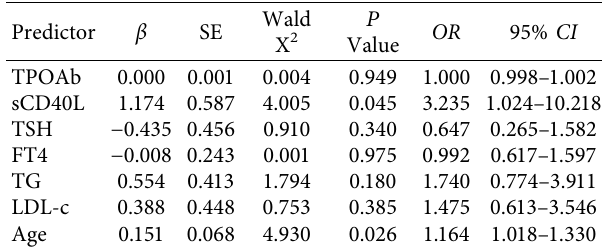
TPOAb, thyroid peroxidase antibody; sCD40L, soluble CD40 ligand; TSH, thyroid-stimulating hormone; FT4, free thyroxine; TG, triglyceride; LDL-c, low-density lipoprotein cholesterol.